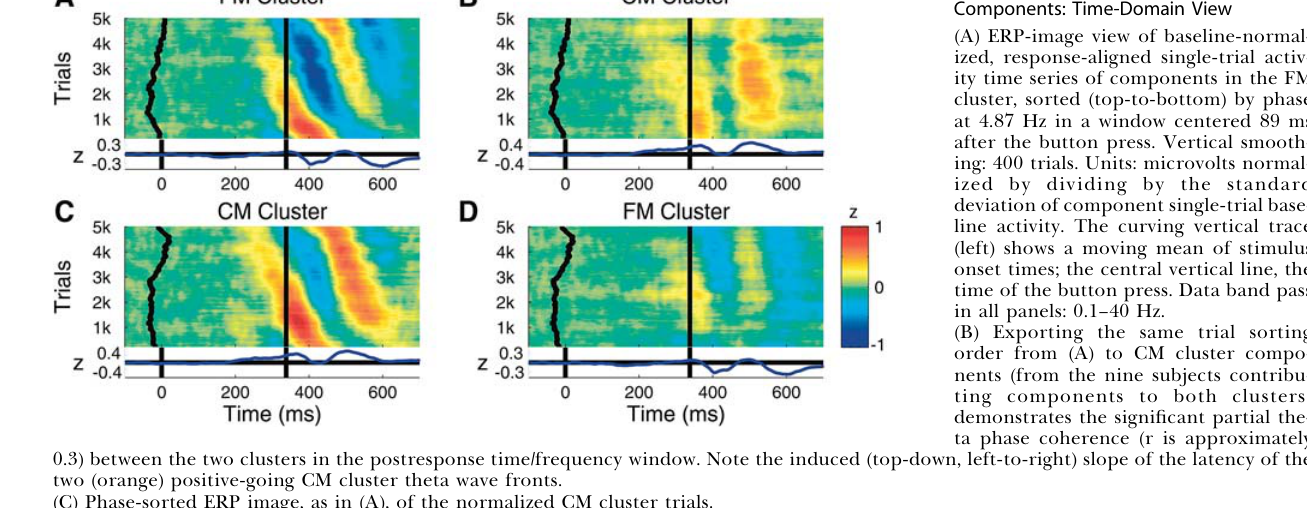
Figure 12. Phase Coupling of Theta Components: Time-Domain View (A) ERP-image view of baseline-normal- ized, response-aligned single-trial activ- ity time series of components in the FM cluster, sorted (top-to-bottom) by phase at 4.87 Hz in a window centered 89 ms after the button press. Vertical smooth- ing: 400 trials. Units: microvolts normal- ized by dividing by the standard deviation of component single-trial base- line activity. The curving vertical trace (left) shows a moving mean of stimulus onset times; the central vertical line, the time of the button press. Data band pass in all panels: 0.1–40 Hz. (B) Exporting the same trial sorting order from (A) to CM cluster compo- nents (from the nine subjects contribu- ting components to both clusters) demonstrates the significant partial the- ta phase coherence (r is approximately